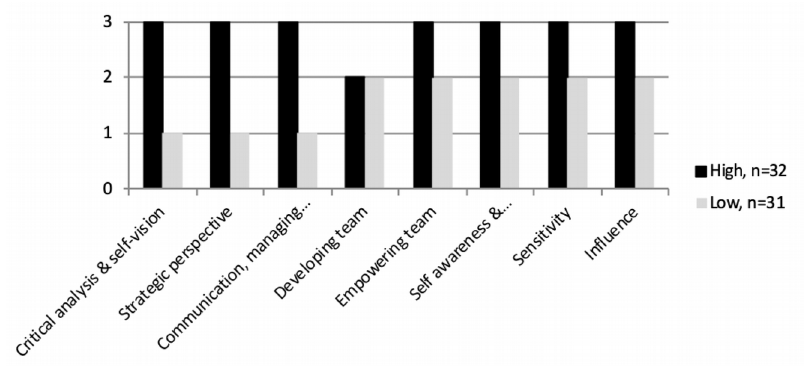
Figure 2. Leadership Profiles for More and Less Successful Projects Configuration